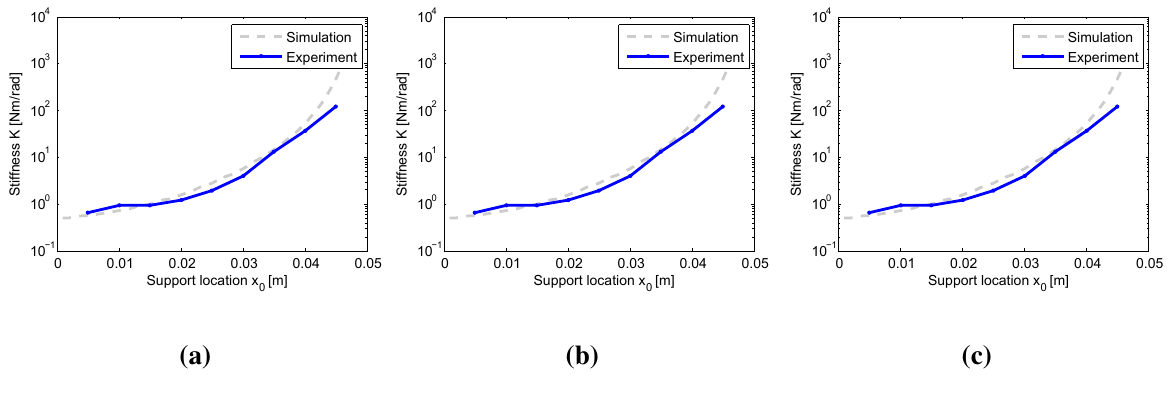
Figure 18. Stiffness/support location plots for a double-leaf spring based on a linear least squares approximation to the deflection/torque data. The simulated line is adapted using the measured effect of the double-leaf spring and the clamps with respect to a single-leaf spring.